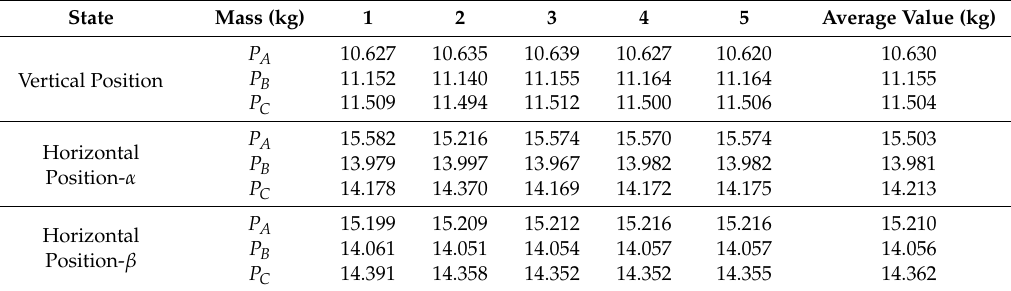
Table 12. Unloaded satellite three-point experimental data.